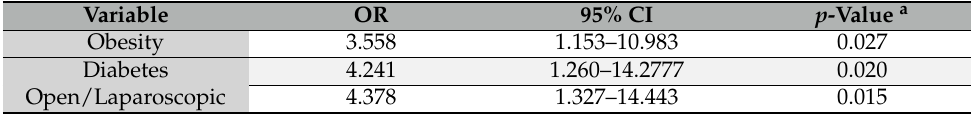
Table 2. Factors associated with occurrence of anastomotic leakage.